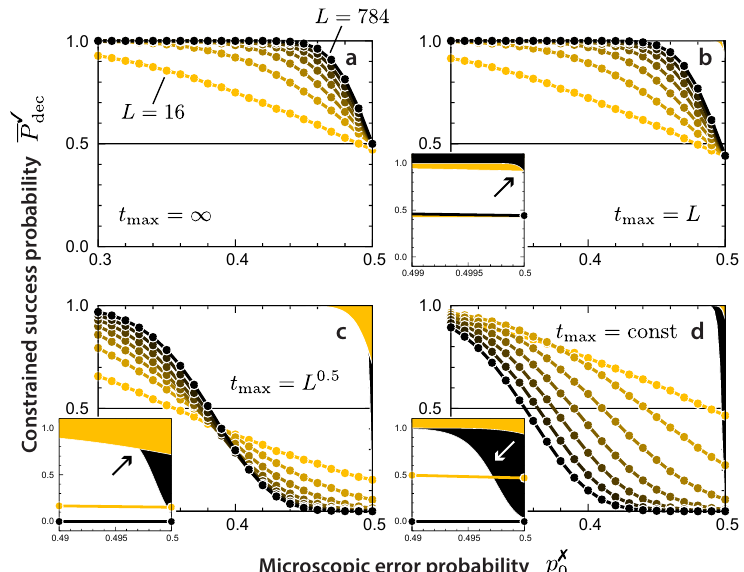
(cid:51) of successfully dec (cid:55) us- 0 ( L ) steps max